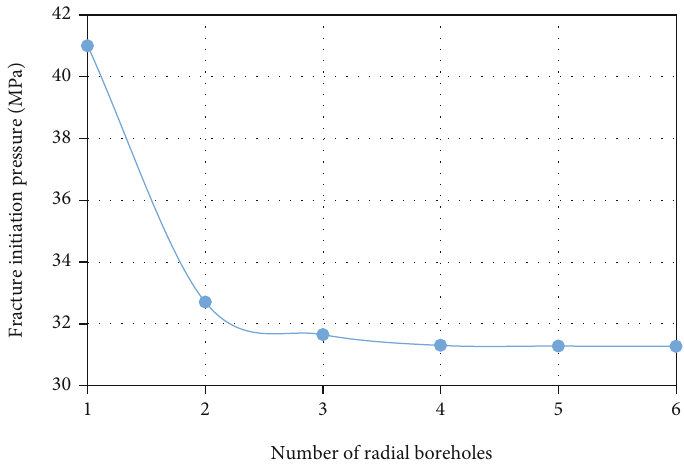
Figure 20: FIP with di ff erent number of radial